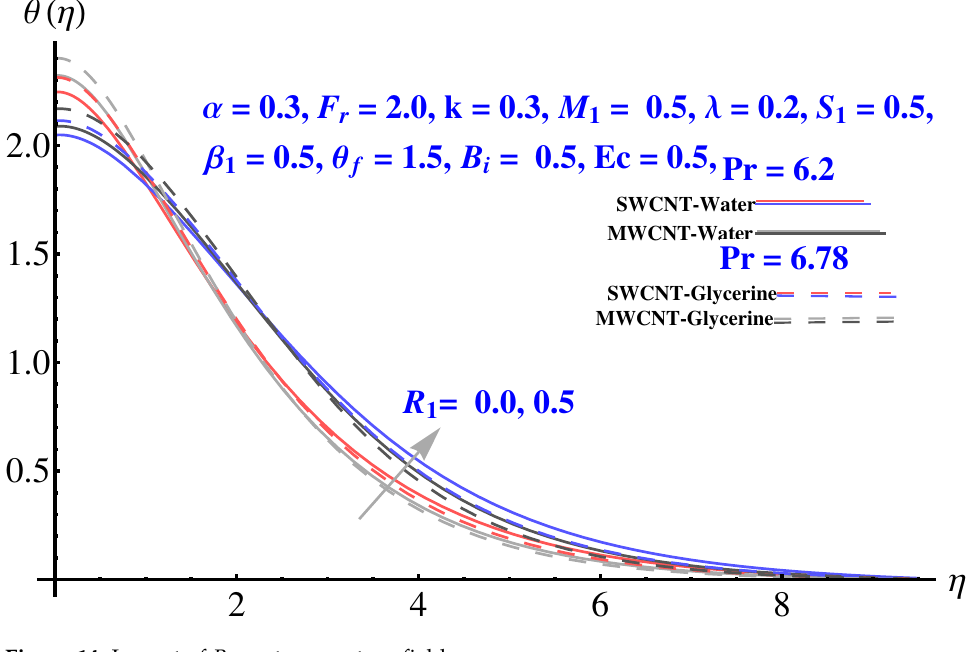
Figure 14. Impact of R 1 on temperature